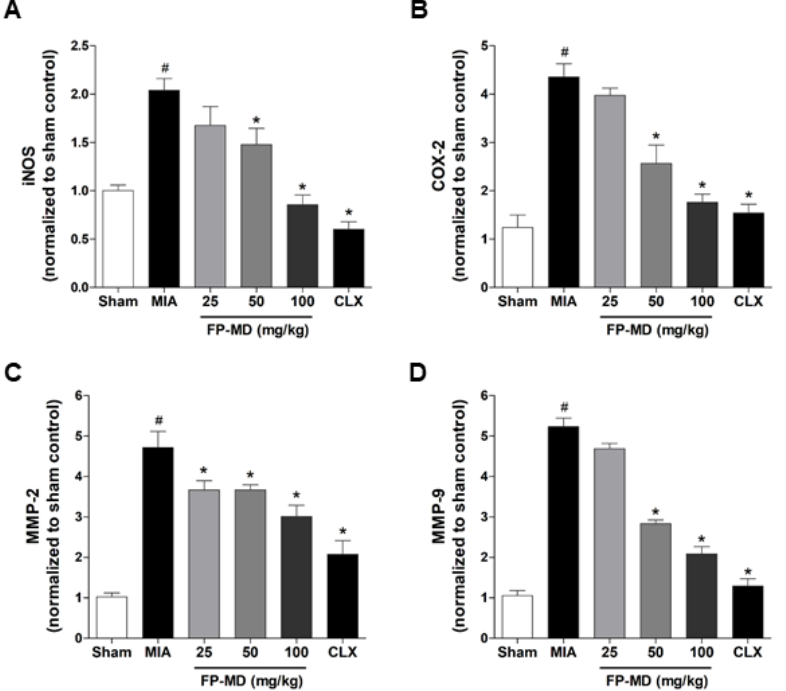
Figure 5. Effects of oral administration of FlexPro MD ® (FP-MD) on the expression of inflammatory mediators and metalloproteinases (MMPs) in the knee joint in monosodium iodoacetate (MIA)-induced osteoarthritis (OA) rats. The mRNA expression of ( A ) inducible nitric oxide synthase (iNOS), ( B ) cyclooxygenase-2 (COX-2), ( C ) MMP-2, and ( D ) MMP-9 in FP-MD (25–100 mg / kg) + MIA- or Celecoxib (CLX) (3 mg / kg) + MIA-induced OA rats were compared to those of the vehicle-treated MIA group. Data are expressed as the mean ± S.E.M ( n = 8). # p < 0.05 versus vehicle-treated Sham group and * p < 0.05 vs. MIA.